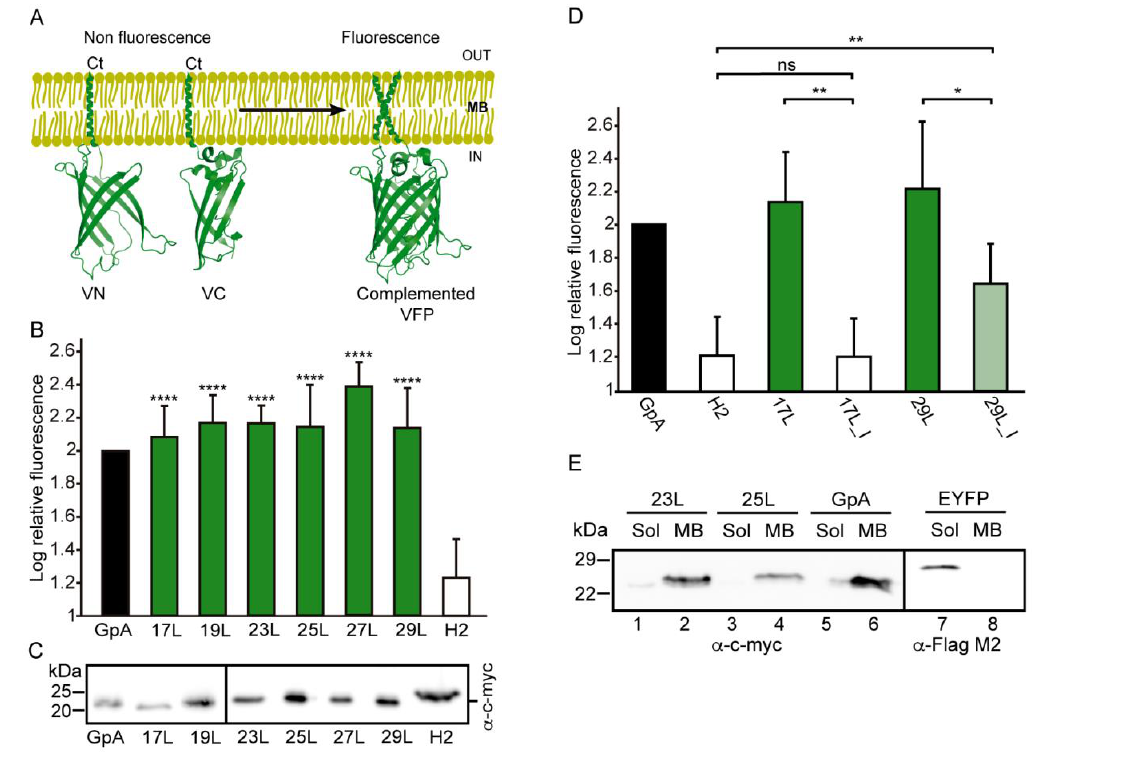
FIGURE 2: Homo-dimerization in eukaryotic membranes. (A) Schematic representation of BiFC Assay. TM-driven oligomerization results in comple- mentation of two non-fluorescent halves (amino-terminus (VN) and carboxy-terminus (VC)) of the Venus Fluorescent Protein (VFP). (B) Mean relative fluorescence of chimera homo-oligomerization in HEK293T cells (GpA (VN-GpA/VC-GpA), 17L (VN-17L/VC-17L), 19L (VN-19L/VC-19L), 23L (VN- 23L/VC-23L), 25L (VN-25L/VC-25L), 27L (VN-27L/VC-27L), 29L (VN-29L/VC-29L), H2 (VN-H2/VC-H2)). Error bars indicate standard deviation obtained from at least 4 independent replicates (H2 was used as a negative control, **** < 0.0001). A color intensity code is used to highlight dimerizing (green) and non-dimerizing (white) transmembrane segments, while positive dimerization control (GpA) is shown in black. (C) Western Blot show chimera’s expression levels detected by α-c-Myc antibody. (D) The contribution of Gly for the dimerization of TM chimeras . Relative fluorescence of chimera homo-oligomerization in human-derived HEK293T cells (GpA [VN-GpA/VC-GpA (depicted in black)], H2 [VN-H2/VC-H2] (white), 17L [VN- 17L/VC-17L], 17L_I [VN-17L_I/VC-17L_I], 29L [VN-29L/VC-29L], 29L_I [VN-29L_I/VC-29L_I). The bars represent mean values of chimera homo- oligomerization, and error bars denote standard deviation obtained from 3 independent experiments (p-values of Student’s t-test: * < 0.05, ** < 0.01, ns (non-significant)). Color intensity is used to highlight dimerizing (significantly different from H2 control, green) and non-dimerizing (white). Light green is used to indicate those samples (where the Gly residues of the dimerization domain have been substituted with Ile) which fluorescence values are significantly higher than the H2 control and at the same time lower than the corresponding non-mutated control. (E) Cellular fractionation of chimera expressing eukaryotic cells . Subcellular fractionation of HEK293T cells expressing BiFC chimeras (c-Myc tagged) (VN-23L, VN-25L and VN- GpA) or EYFP (Flag-tagged) (used as a soluble marker). Soluble fraction (Sol) and Membrane fraction